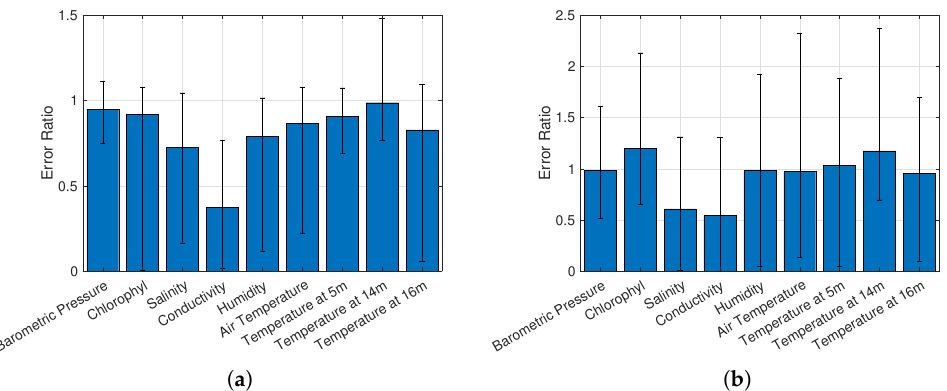
Figure 6. The ratios between the prediction errors (7) when using all N possible related datasets vs. when using a subset of N − 1 datasets. The bar labels (bottom) indicate the removed dataset in each of the cases, bar level indicates the mean value while error bars represent the 95% confidence